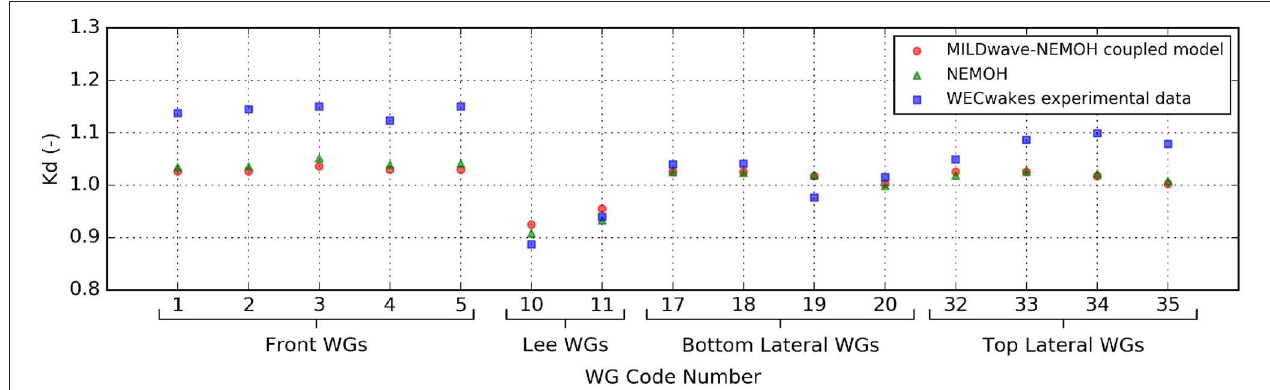
FIGURE 8 | Comparison of the wave height obtained experimentally and numerically with a coupled MILDwave-NEMOH model (Verao Fernández et al., 2019). The K d coefficient is defined as the ratio between the numerically calculated and the target significant wave height, and the wave height has been recorded by wave gauges (WG) in an array of nine heaving damped